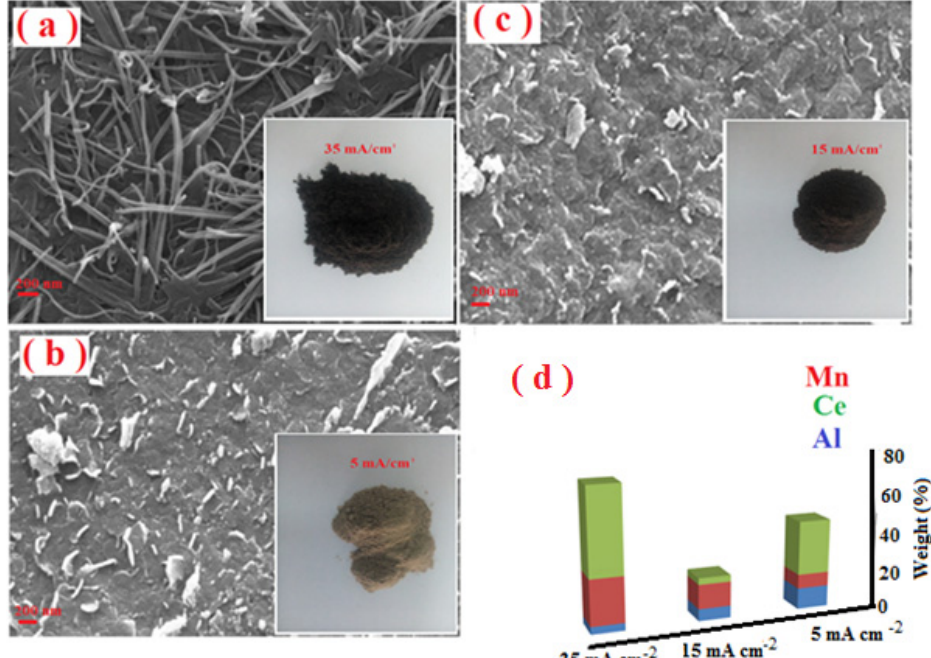
Fig. 1, SEM images of synthesized samples at (a) 35, (b) 15 and (c) 5 mAcm -2 current density. (d) Results of Energy dispersive X-ray (EDX)